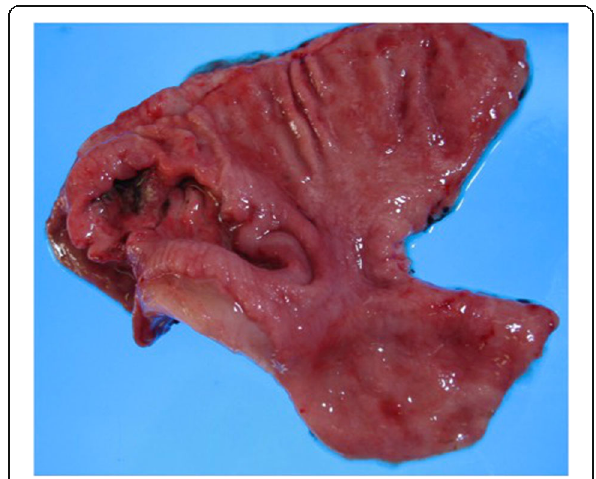
Fig. 1 Resected specimen. Resected specimen showed a circumferential type 3 tumor at the pyloric antrum of the stomach